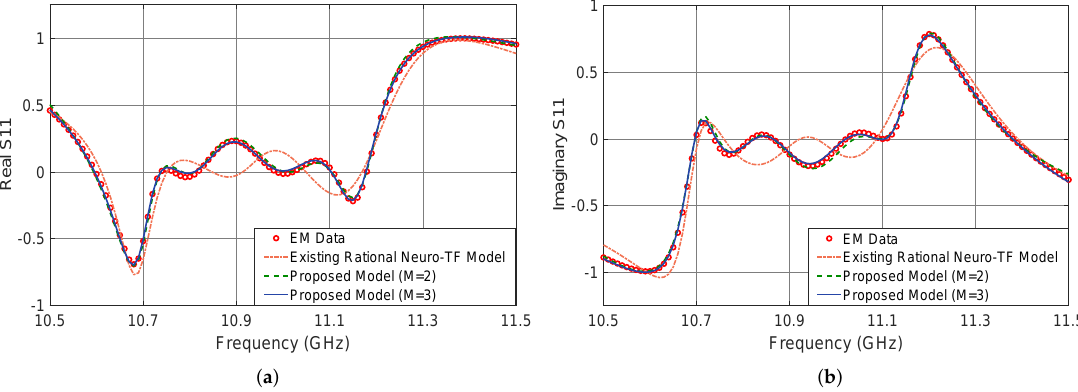
Figure 10. Comparison of Re ( S 11 ) and Im ( S 11 ) for different modeling approaches and EM data at test sample x = [ 3.36 4.38 4.00 3.36 3.02 ] T (mm) for the four-order bandpass filter example. ( a ) Re ( S 11 ) and ( b ) Im ( S 11 )